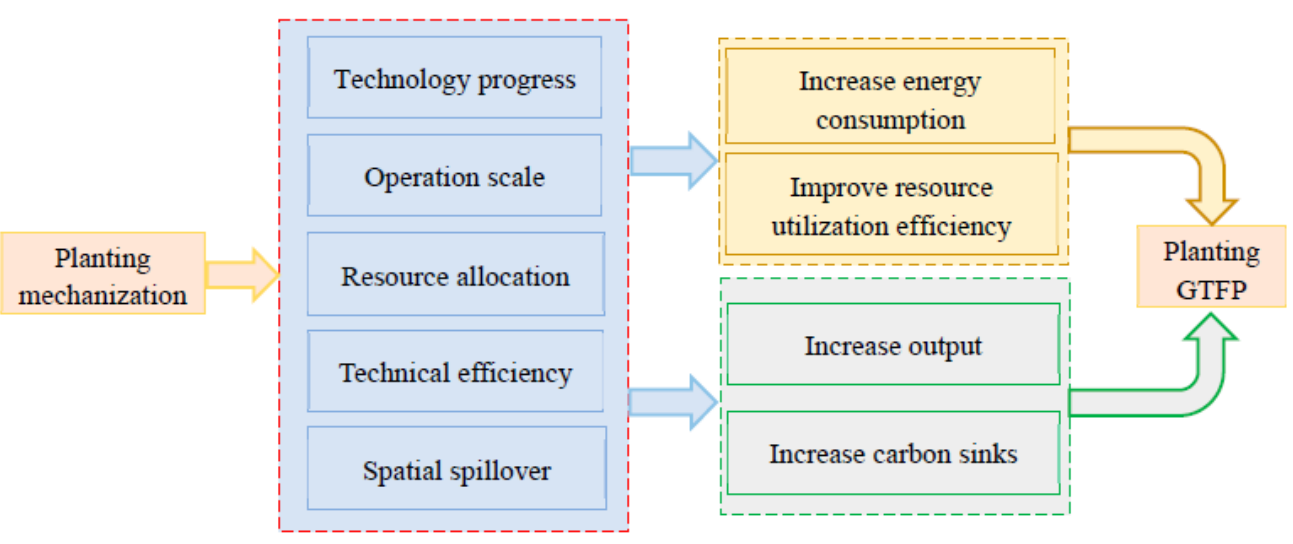
Figure 2. Influence mechanism of mechanization on planting GTFP.